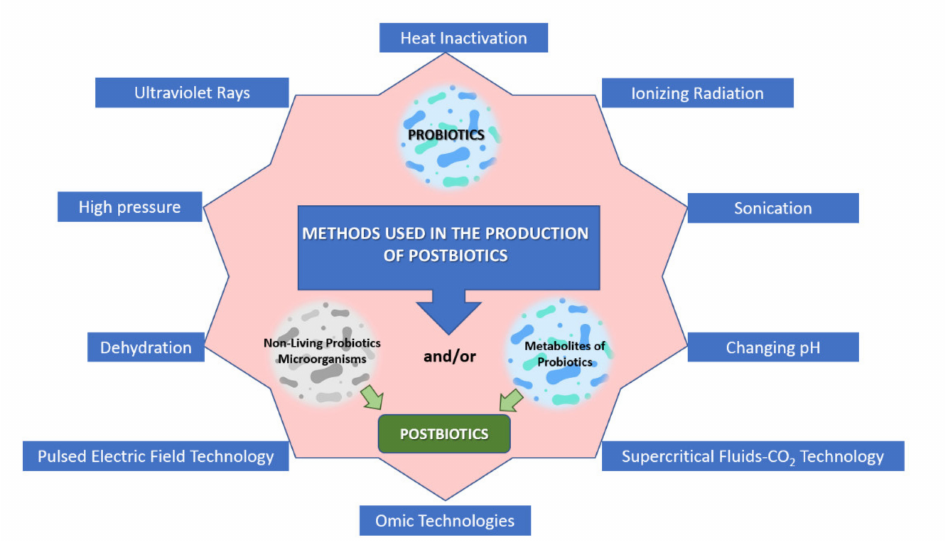
Figure 1. Methods used in the production of